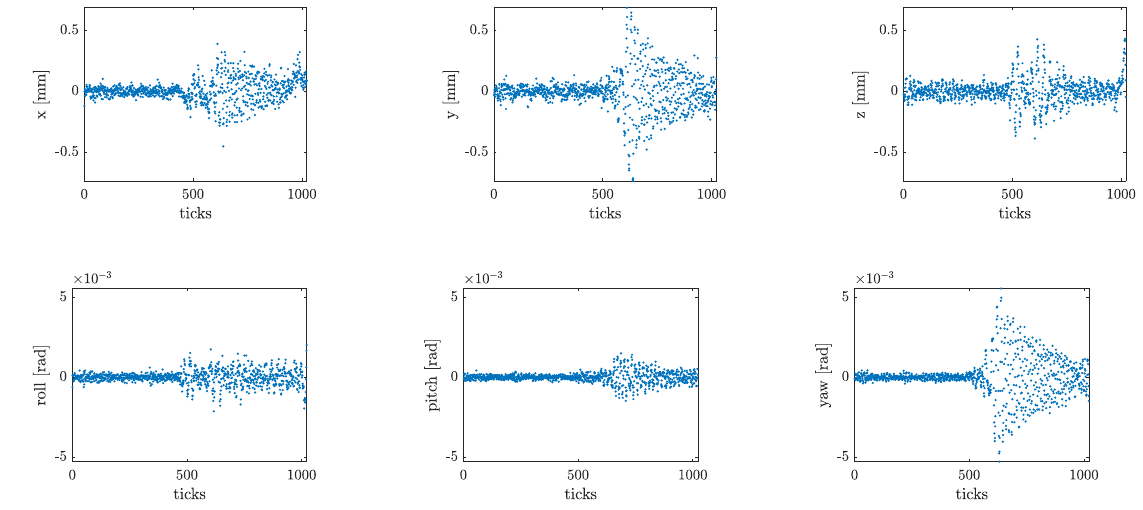
Figure 6. Residuals of the forward proceeded iEKF.